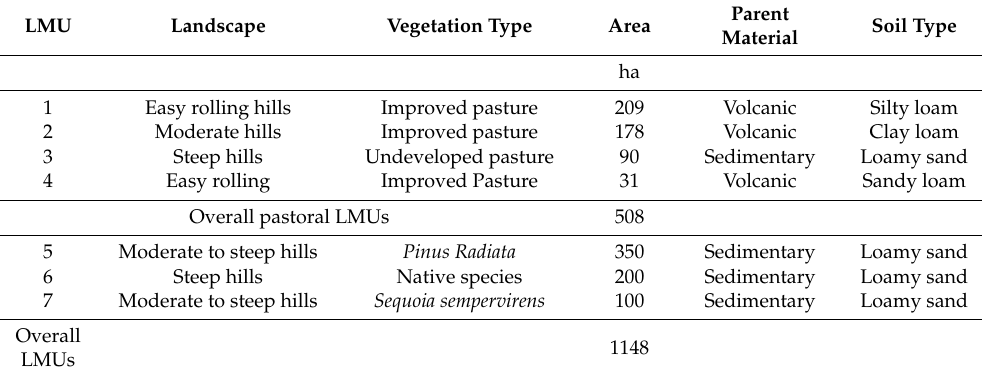
Table 3. Landscape, vegetation, parent materials and soils for each of the land management unit (LMU) of the farm-level case (Base